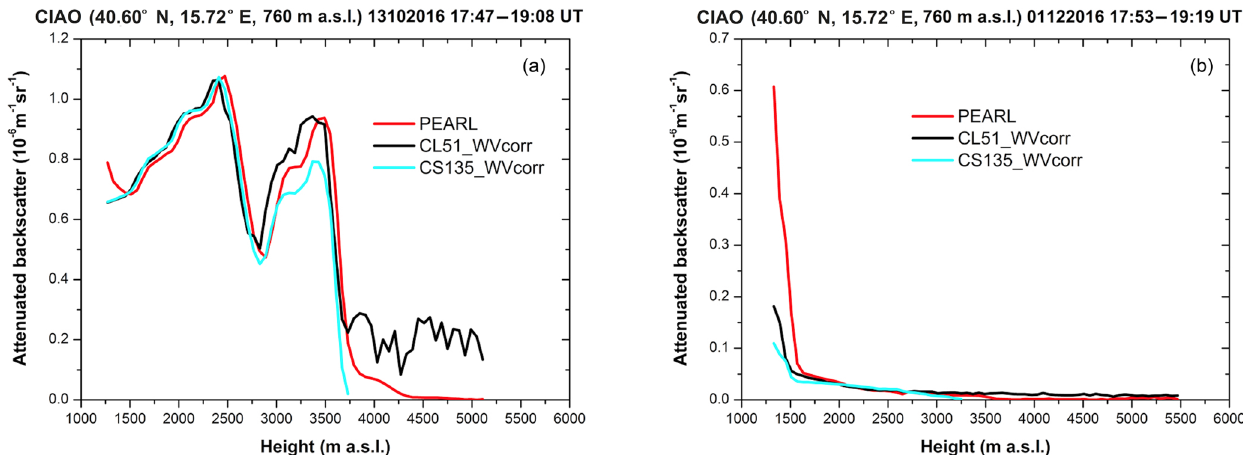
Figure 8. (a) Comparison between the attenuated backscatter profiles retrieved from PEARL, CL51 and CS135 on 13 October 2016 in the time interval from 17:47 to 19:08UT and obtained normalizing the ceilometer profiles on the PEARL profile in the region between 1.8 and 3.0km. (b) Same as (a) , but for the 1 December 2016 in the time interval from 17:53 to 19:19UT. All the ceilometer profiles are corrected for the water vapor absorption affecting the signal extinction at 910–912nm.